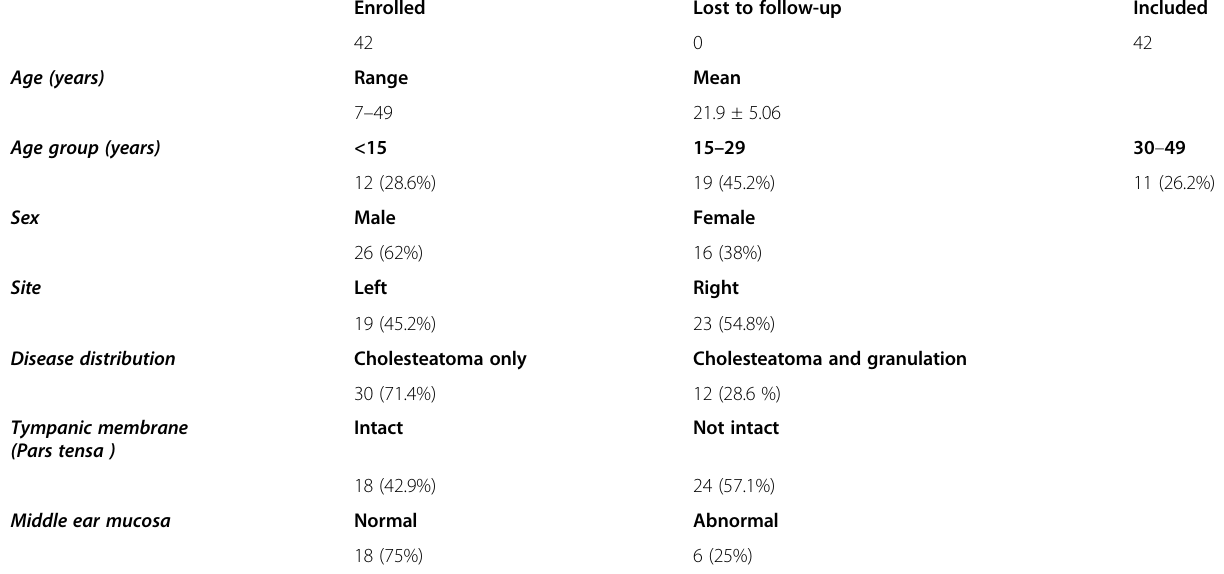
Table 1 Distribution of enrolled